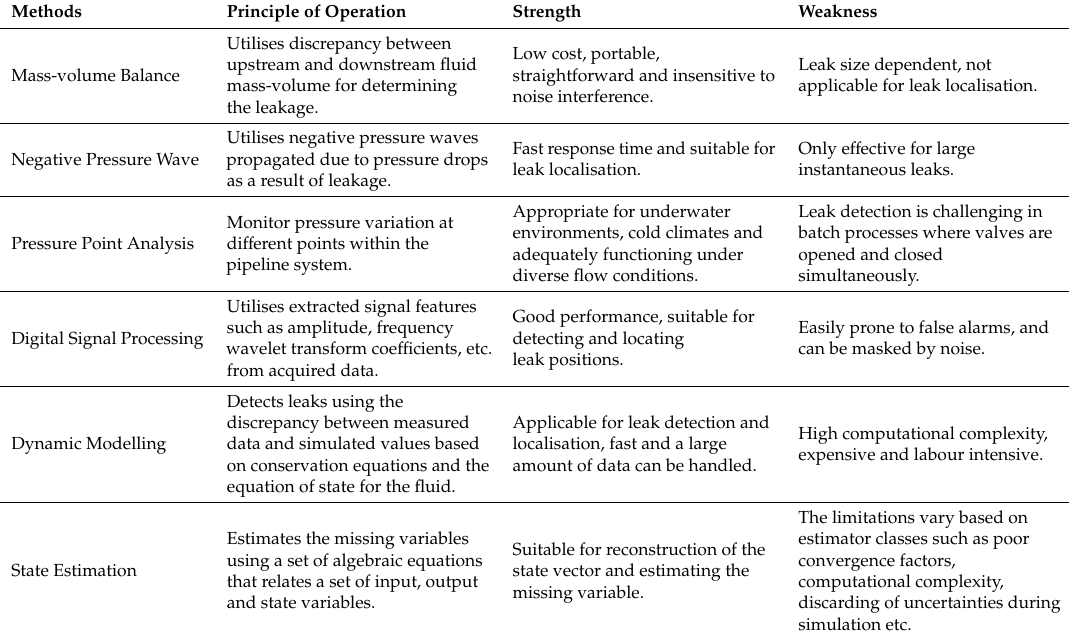
Table 2. Summary of the interior pipeline leak detection